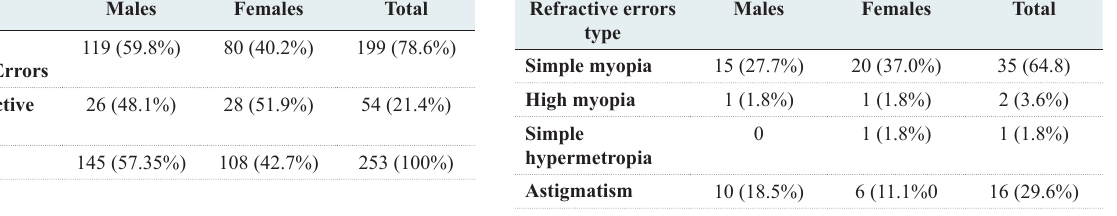
Table 2: Prevalence rates of different types of refractive